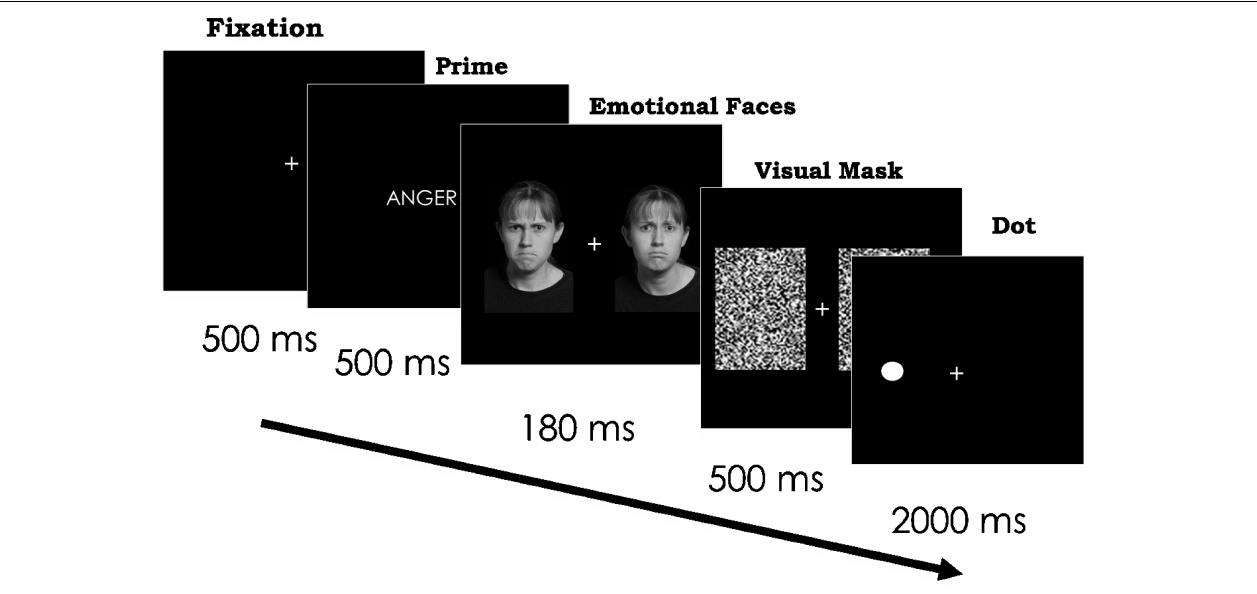
FIGURE 3 | Paradigm and timing for Experiment 2. Scowling face on the left and frowning face on the right. In separate trials, the same two faces followed the word “sad” and a control word. Each face appeared on the right and left, across trials. In addition, the dot appeared on the right and left, across trials. Stimuli images are from IASLab face set (http://www.affective-science.org) and depict adult participants from Boston College. Participants in this face set gave written and informed consent, including explicit consent to be photographed and their likeness to be reproduced.